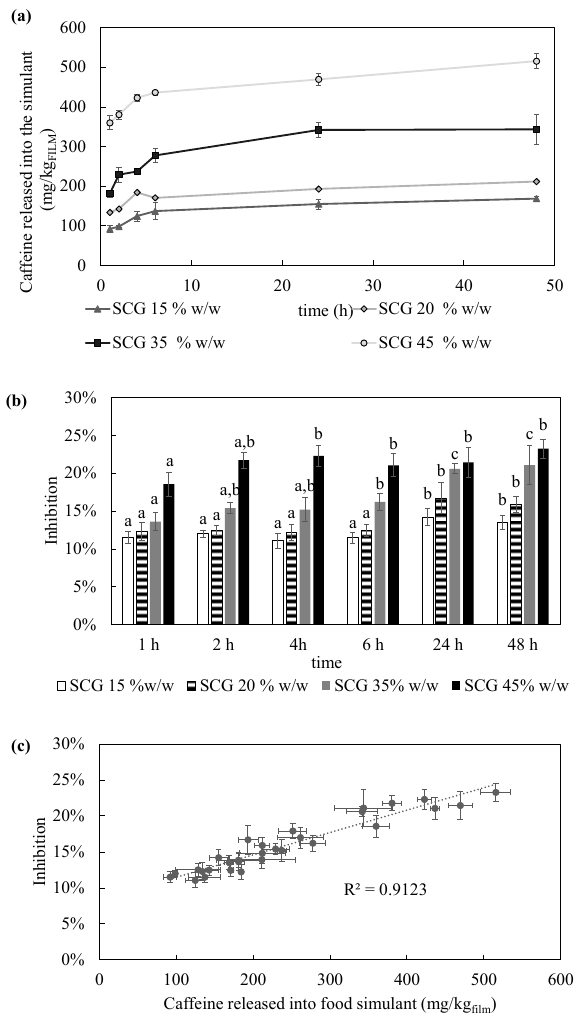
Figure 5. Results of the release tests on films obtained by solvent casting in ethanol 10% ( v / v ), in terms of: ( a ) caffeine released per kg of film, ( b ) radical ABTS • + inhibition, and ( c ) linear correlation between the caffeine concentration released and radical inhibition power of the extract migrated into the food simulant. Different symbols indicate statistically significant differences among values over time (p < 0.05) of the dataset with the same extract loading.